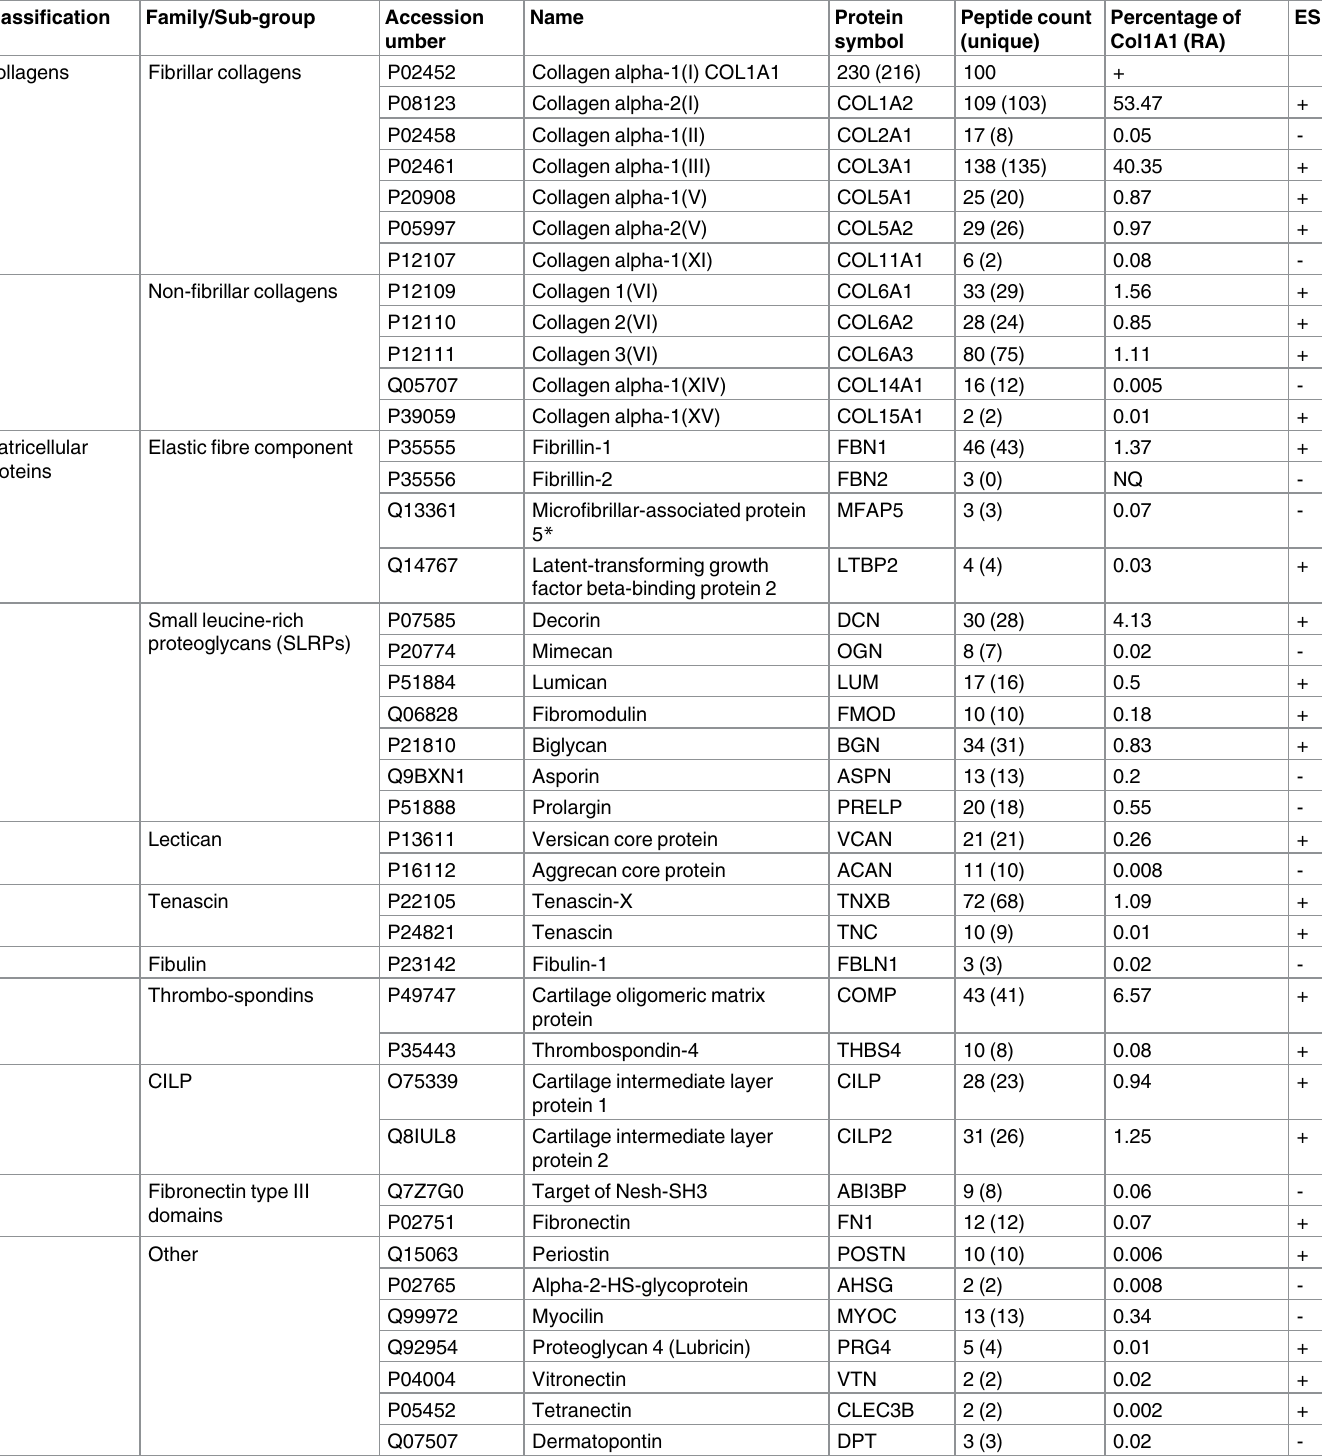
Table 2. Identified collagens and matricellular proteins, showing accessionnumber, name, peptide count and relative abundance (RA) as mean percentage of COL1A1 in young, healthy samples. ES stands for elastasesamples, and a (+) showingif proteins were identifiedin elastasedigestedsam- ples. NQ is non-quantified, and ( * ) is also known as microfibril-associated glycoprotein-2 (MAGP-2).